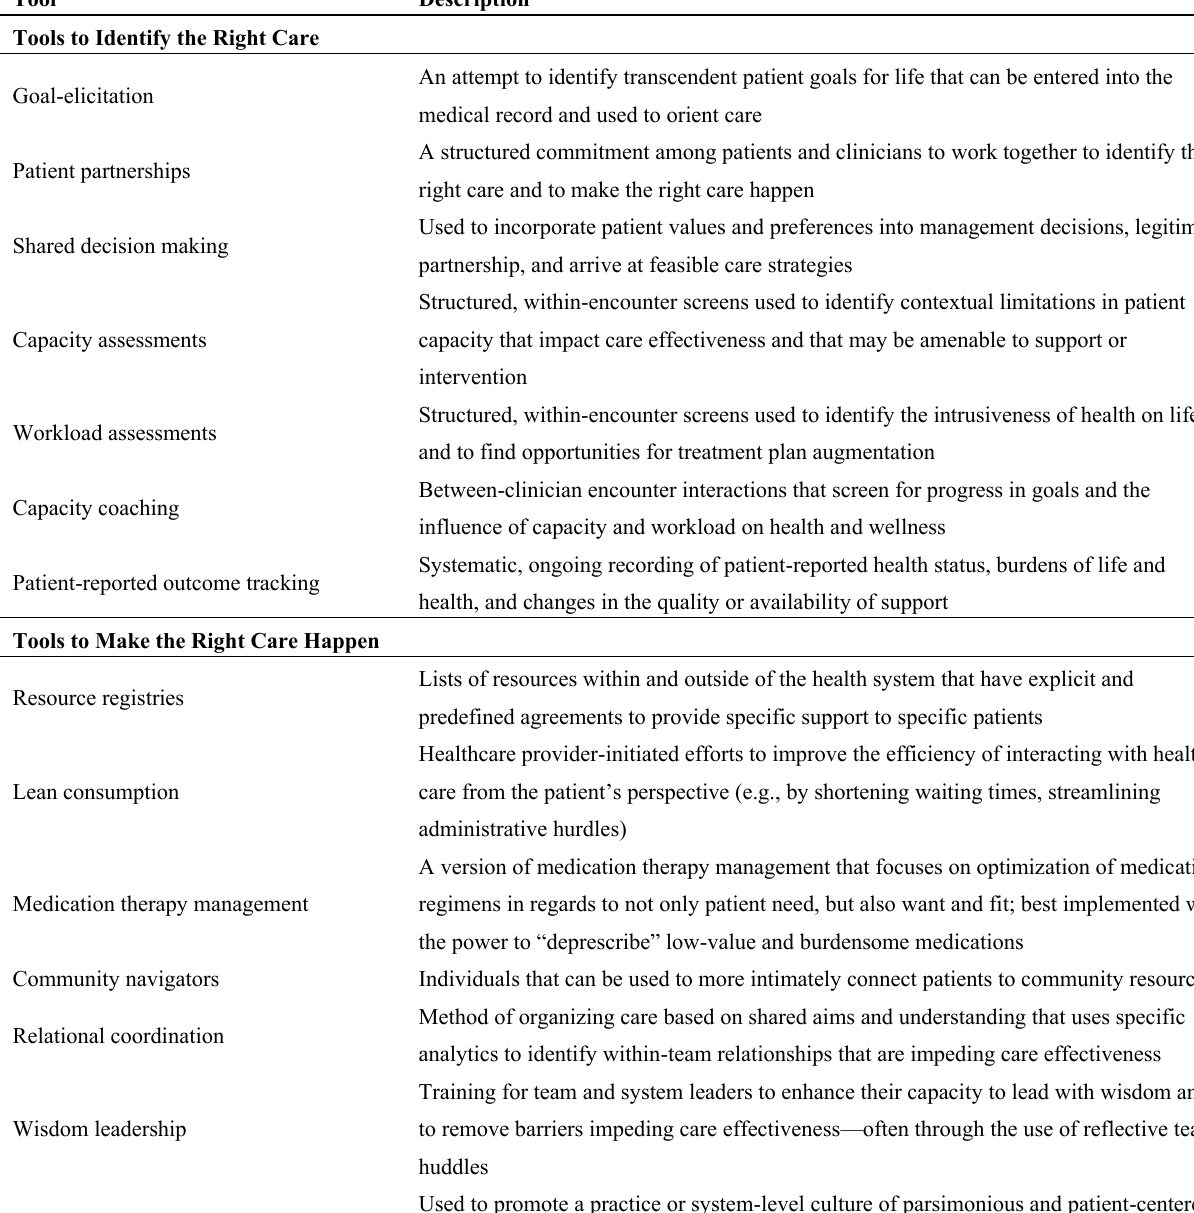
Table 1. The minimally disruptive medicine (MDM)